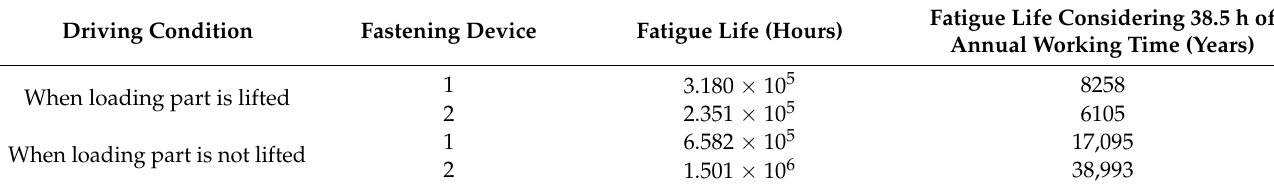
Table 7. Fatigue life of each fastening